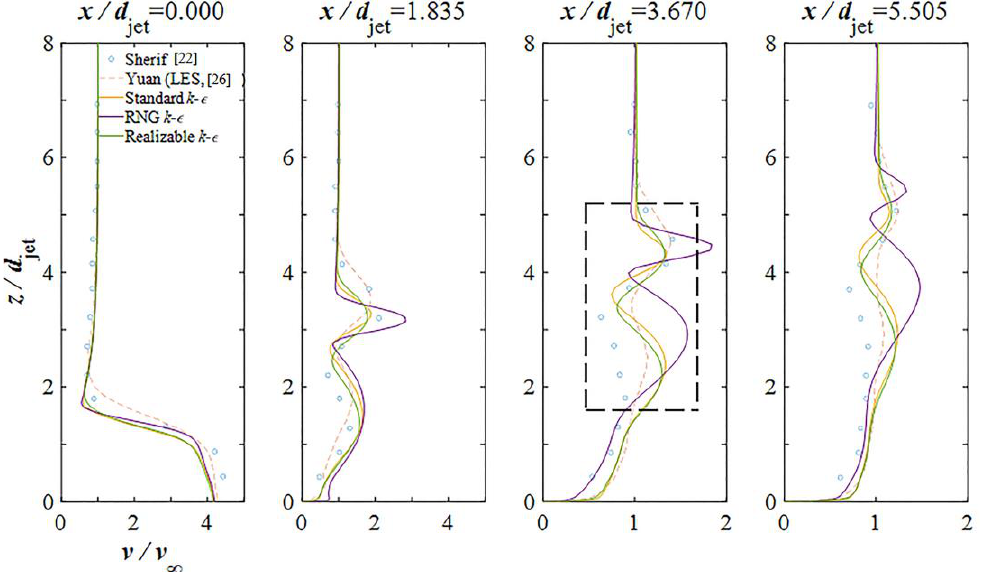
𝜀 model is more desirable.